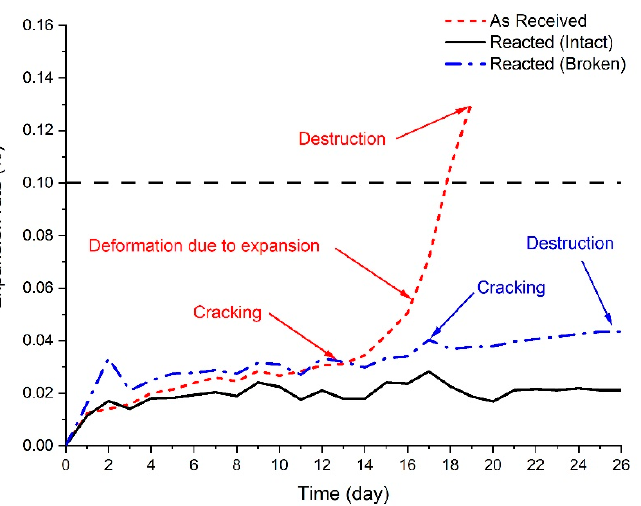
Figure 8. Expansion rate of mortar bar using converter slag as fine aggregate before and after SCD reaction .